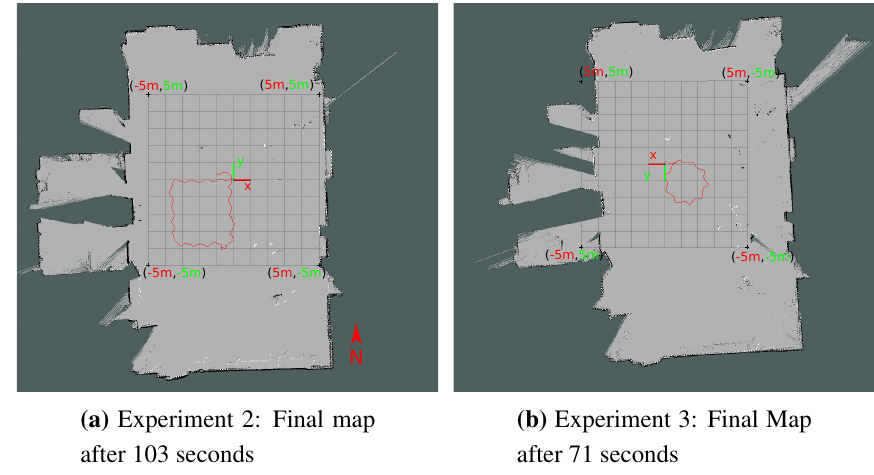
Figure 5. Final 2D maps in the local coordinate system created by HectorSLAM for Experiments 2 ( a ) and 3 ( b ). The maps are consistent and thus serve as input for unwinding the Riegl